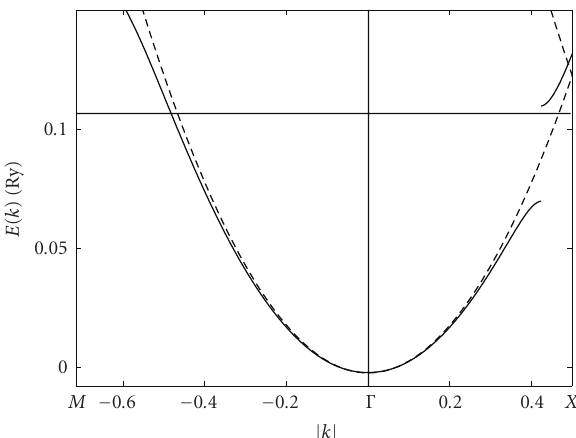
Figure 3: An example of the 2D NFE bands along ( k ,0) and ( k , k ) for q x = q y = 0 . 075 and V q = 20 mRy (full line). The FE band without potential perturbations ( V q = 0) is shown by the broken line. The thin horizontal line is at the DOS minimum, which is situated at 0.15